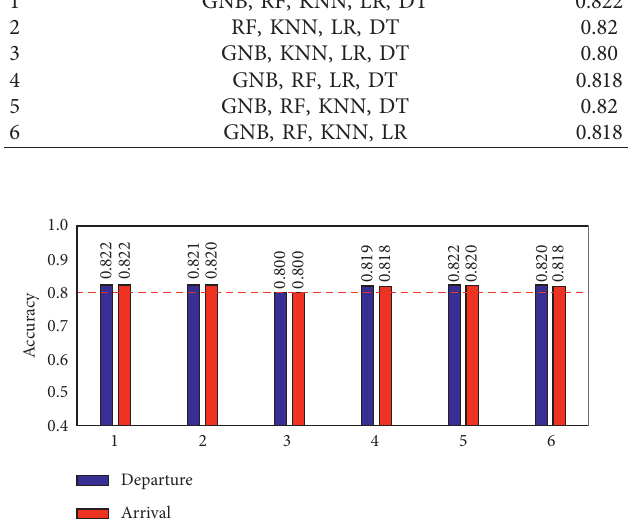
Figure 9: The accuracy of different first-level